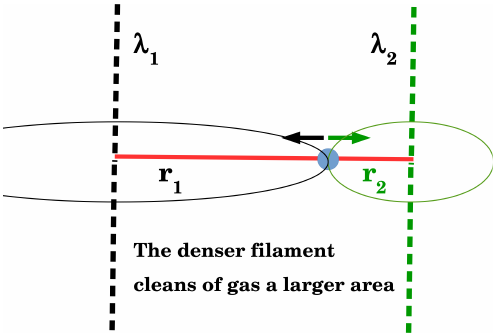
Figure 7. A denser dark matter filament cleans of luminous matter a larger area around it, with radius r ∝ λ . The baryonic matter so accreted forms ordinary galaxies, so a dynamical (not exact) baryonic Tully–Fisher law follows, M luminous ∝ v 4